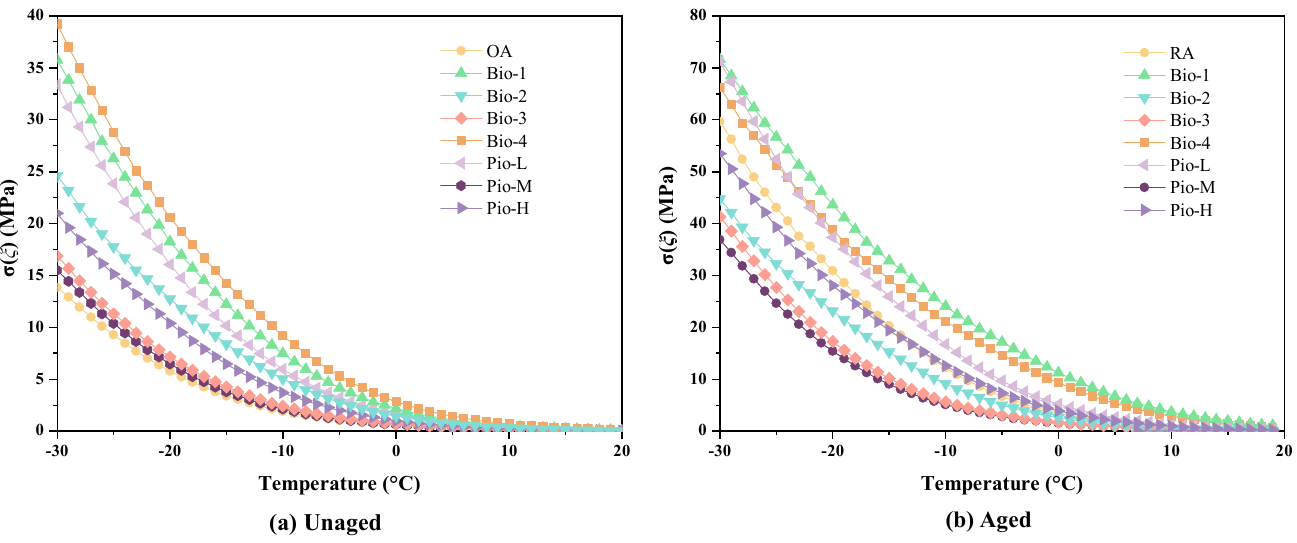
Figure 7. Low-temperature stress curve of ( a ) unaged asphalts ( b ) aged asphalts. There seems to be a correlation between the T CR and σ , where the larger the value of σ (the more the fractions change), the larger the value of the T CR (the worse the low- temperature performance of asphalt). To clarify the specific relationship between the fractions of these rejuvenated asphalts and their low temperature cracking performance, the correlation between the T CR and σ was investigated. The results of the one-dimensional correlation analysis between the σ values of all the 16 asphalt samples and their T CR are shown in Figure 9a, where the correlation coefficient ( R 2 ) is 0.982, which can be considered a strong correlation ( R 2 > 0.900). To further clarify which of the four fractions has a